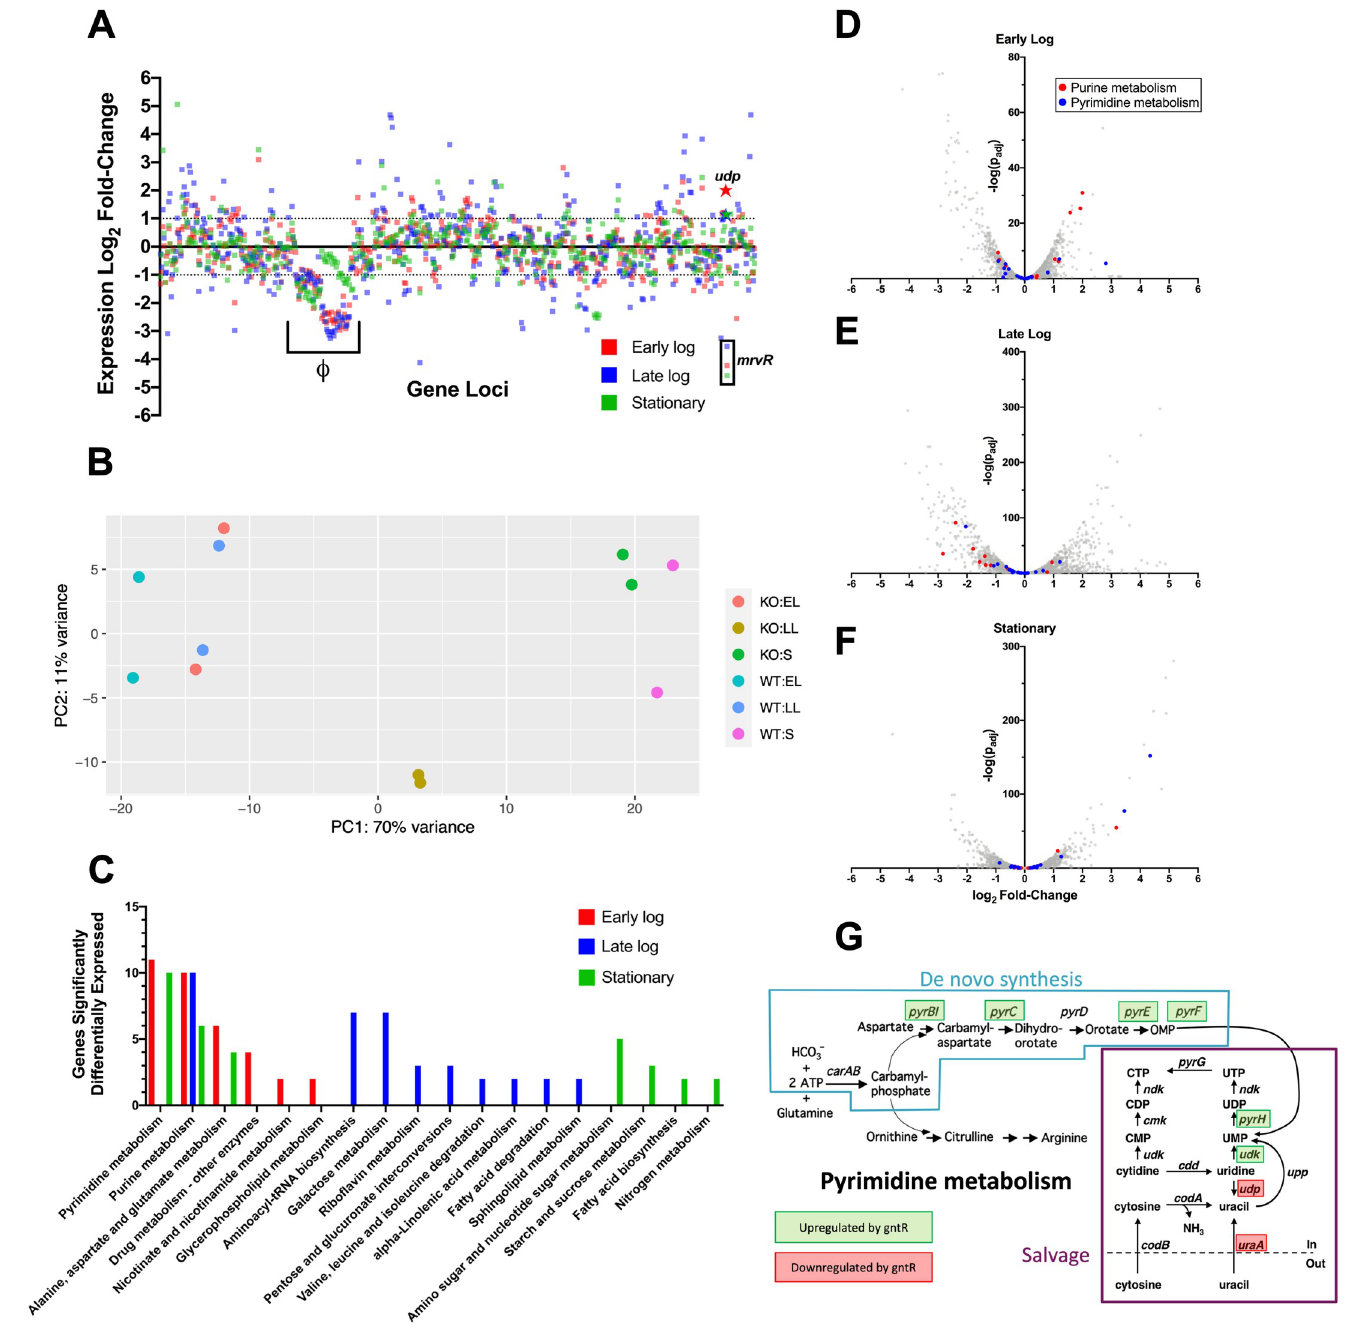
Fig 6. Analysis of the MrvR regulon reveals widespread effects with emphasis on genes involved in nucleotide metabolism. RNA-seq analysis of wild type (WT) and Δ mrvR 10/84 at three growth timepoints showed extensive regulation across the chromosome in all phases of growth ( A , expression log 2 fold-change shown relative to WT). A phage island ( F ) with significant differences from WT is noted, as are the udp gene (stars) and mrvR , which was deleted in the knockout strain. Principal component analysis showed isolated clustering of the late log phase replicates of the knockout strain ( B ). Gene set enrichment analysis showed that, across all three bacterial growth phases tested, the KEGG pathways most influenced by the presence of MrvR were pyrimidine and purine metabolism ( C ), which is also shown in volcano plots ( D-F ). Panel G shows specific genes of the de novo and salvage pathways of pyrimidine metabolism in GBS whose expression is significantly affected by the presence of MrvR (KO = Δ mrvR knockout; EL = early log; LL = late log; S = stationary).